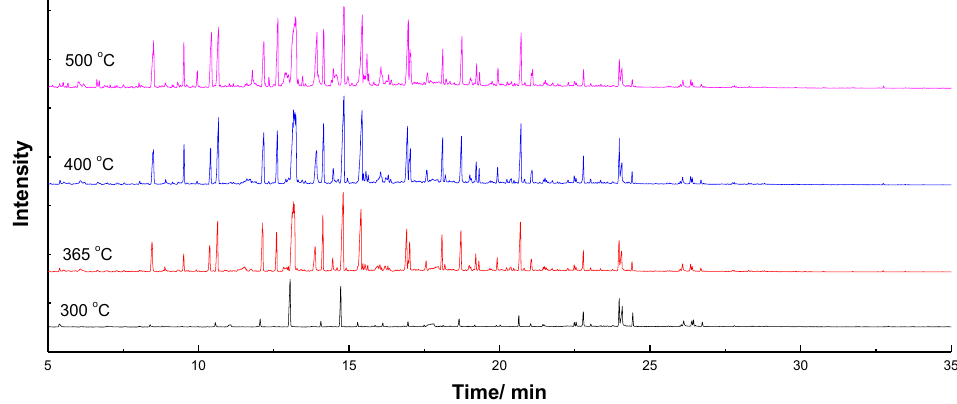
Figure 3. GC/MS diagram of EHL after steam explosion treatment at different temperatures.